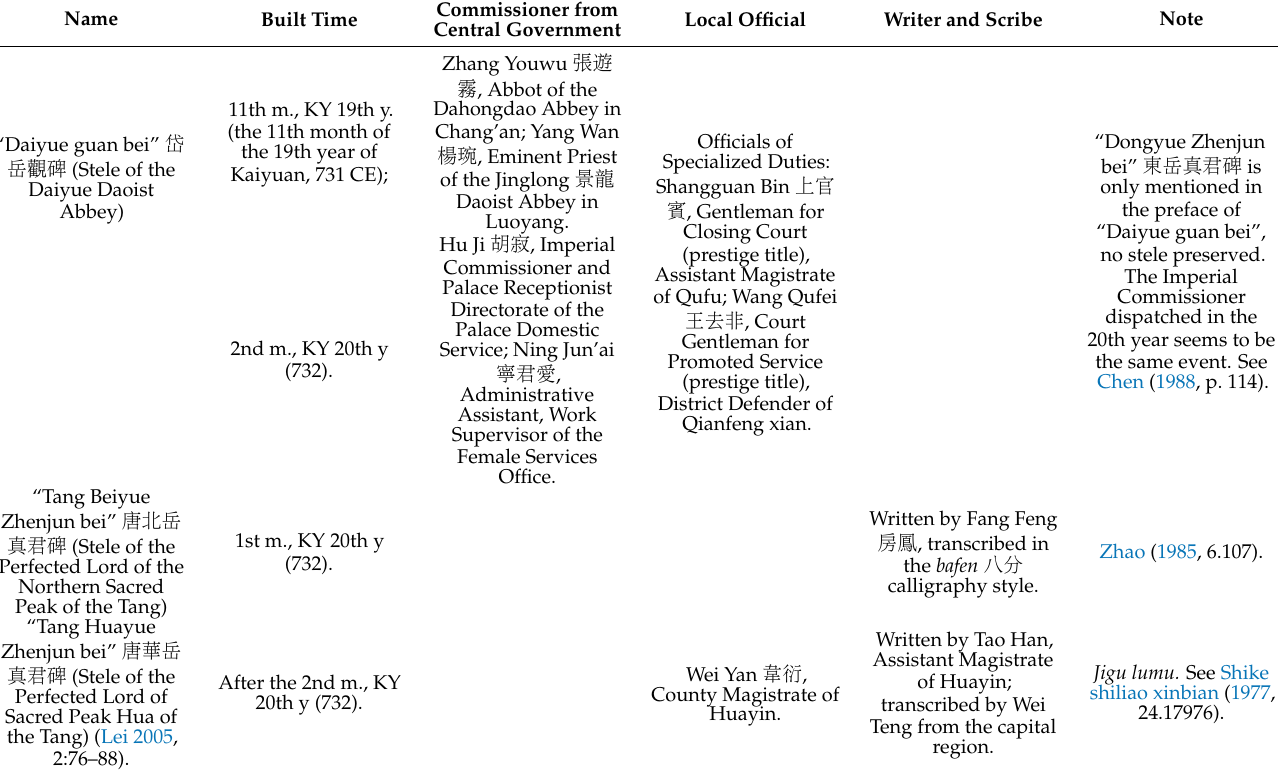
Table 1. Stele inscriptions recording the event of building shrines on the sacred